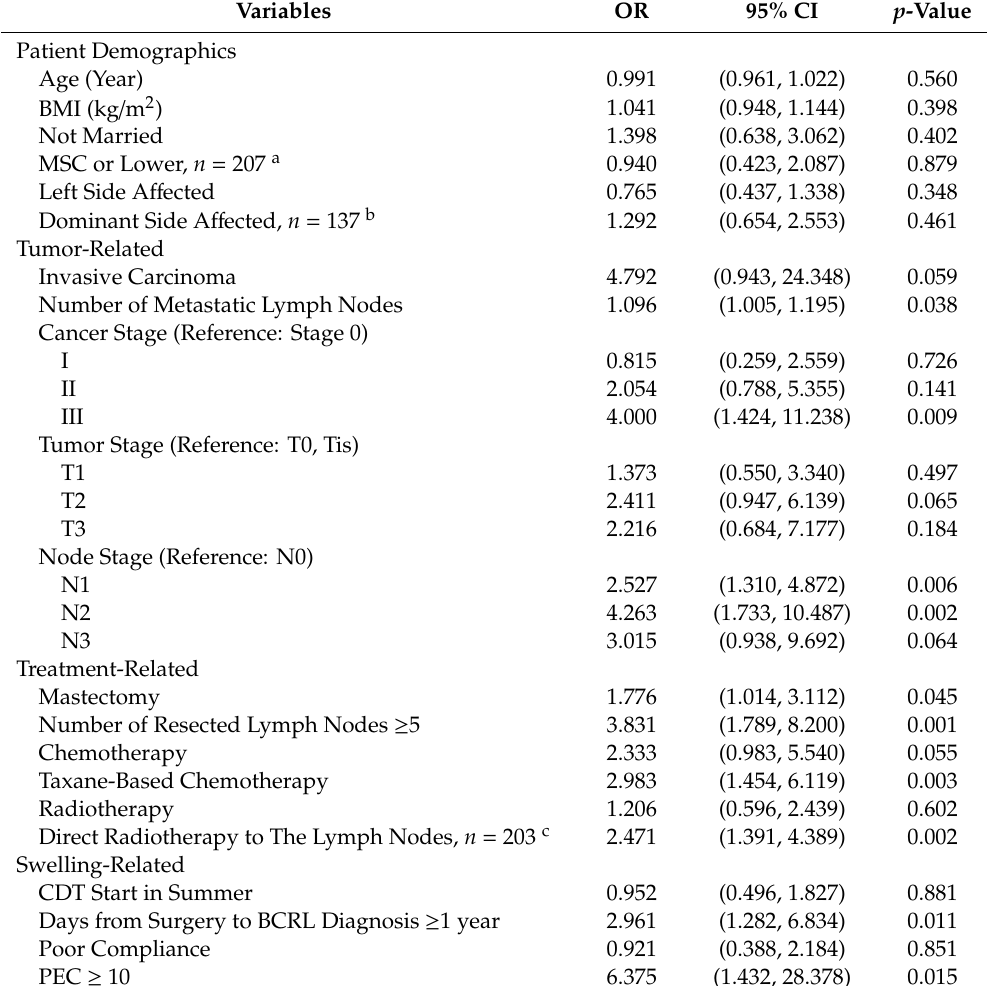
Table 3. Univariate logistic regression analysis for compression-dependent group ( n =